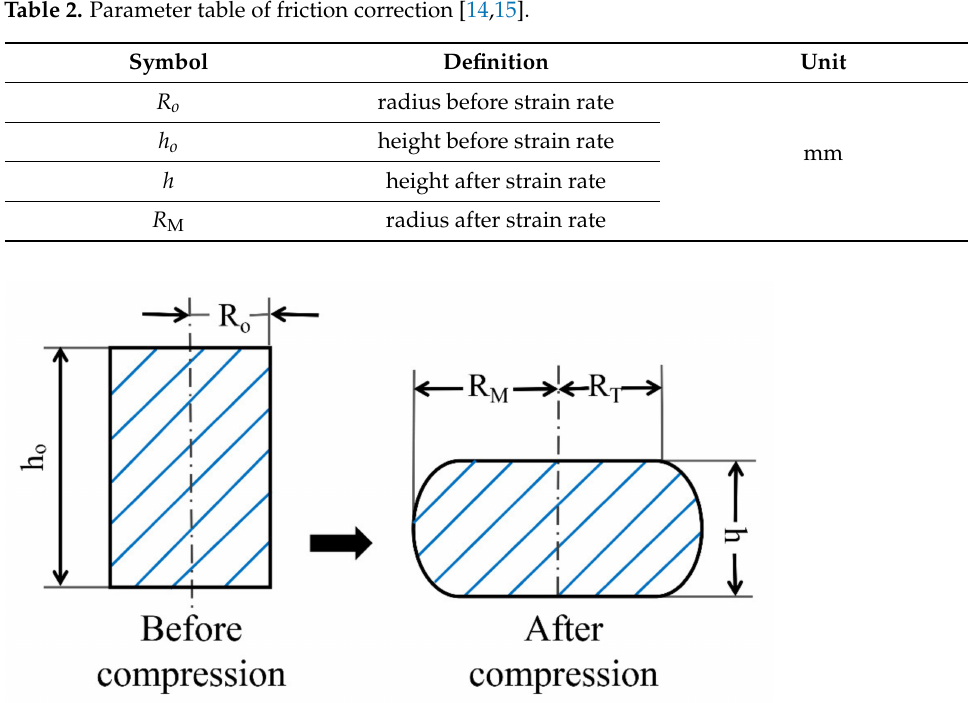
Figure 4. Schematic diagram of F92 steel at a strain of 0.5.